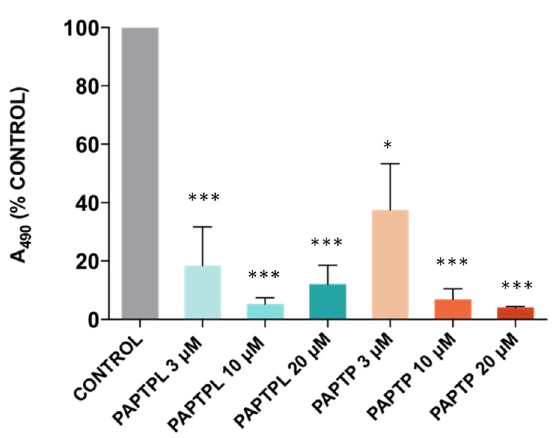
Figure 2. Cell viability of SHSY-5Y cells following treatment for 24 h with the indicated compounds (MTS assay, 490 nm). Values are reported as mean percentage ± standard error of the mean (SEM) of viable cells normalized with respect to untreated cells ( n = 3); each condition was significantly different from control: * p < 0.05, *** p < 0.001, One-way analysis of variance (ANOVA).